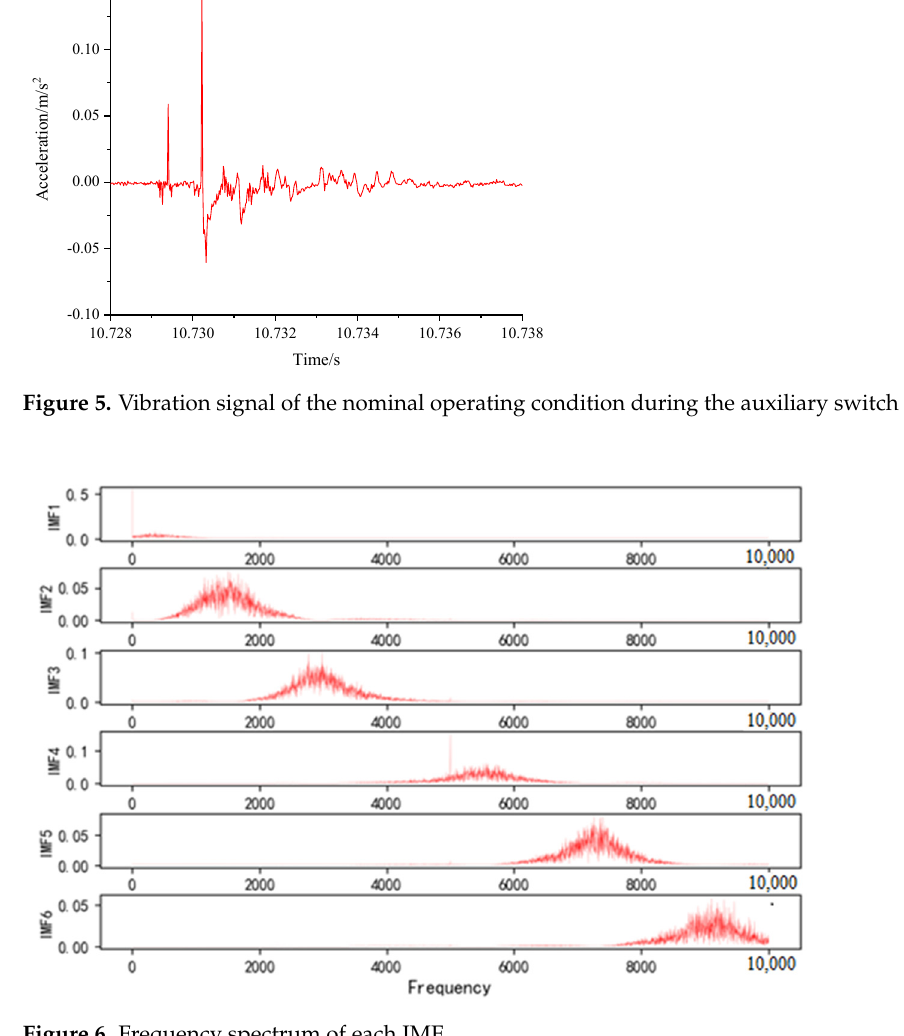
Figure 6. Frequency spectrum of each IMF.